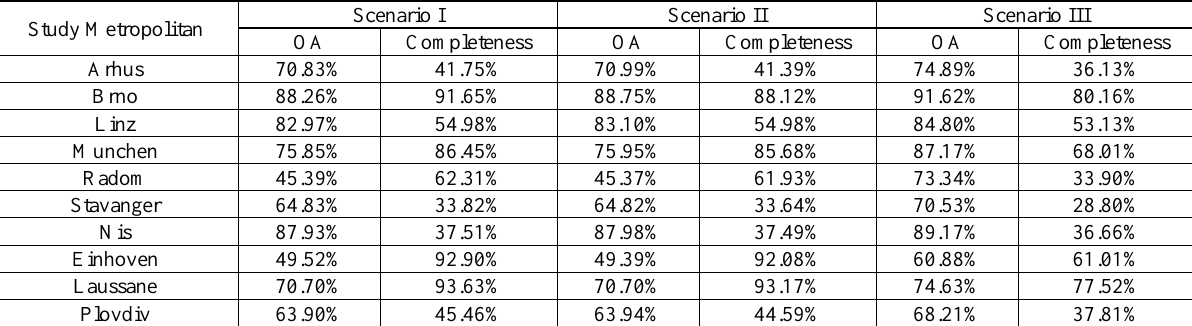
Table3 . LULC mapping considering different scenarios.